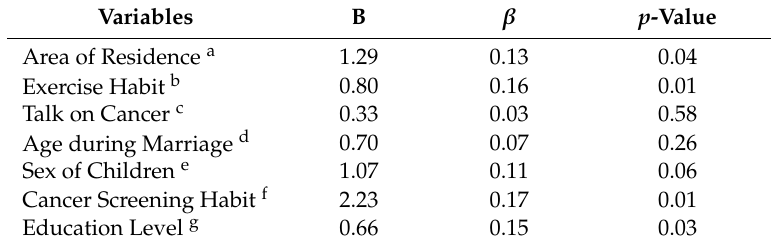
Table 4. Multiple linear regression to identify the predictors of awareness on mothers.